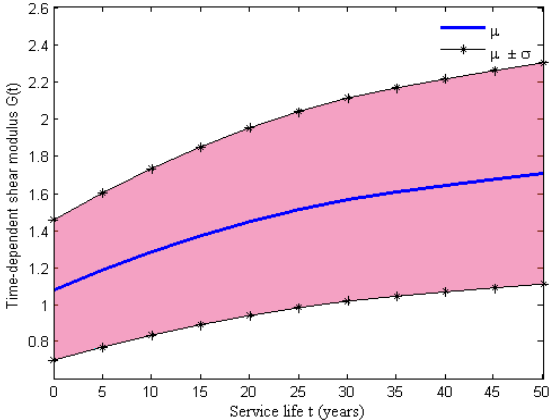
Figure 10. Time evolution of the shear modulus in a bearing NR pad.